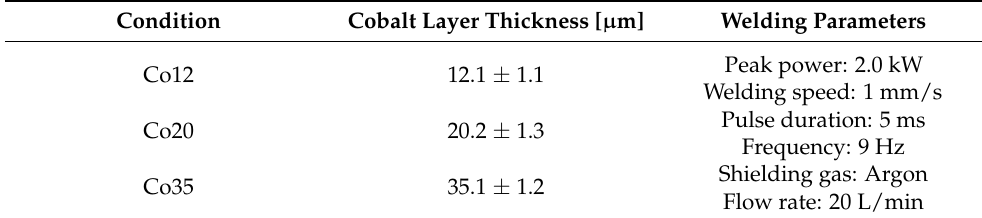
Table 2. Cobalt electrodeposited layers and welding parameters.